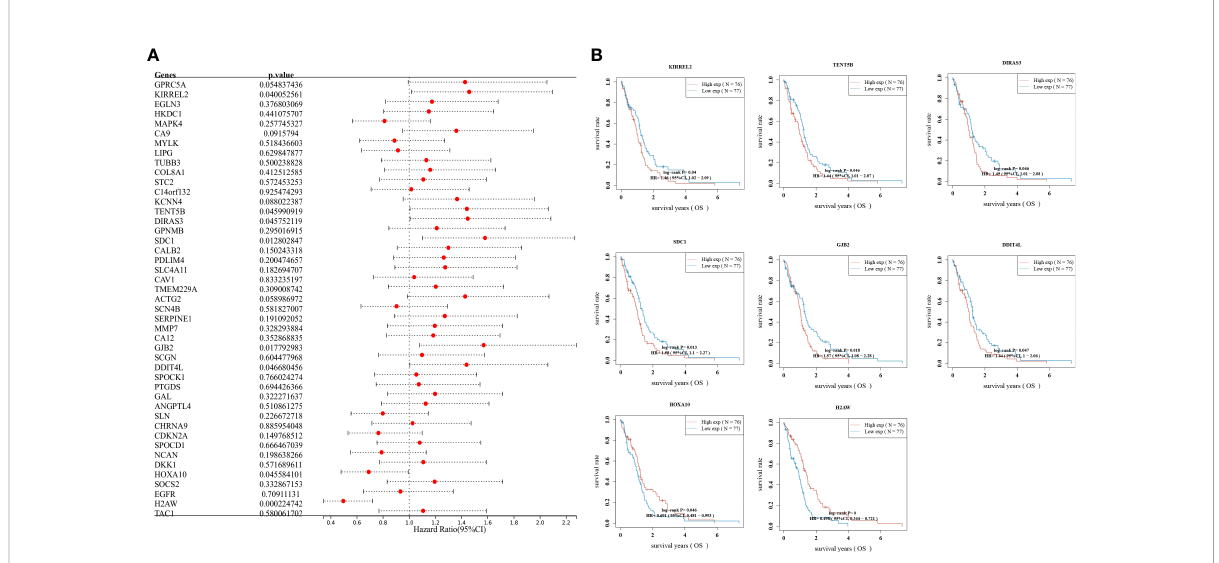
FIGURE 3 Prognostic analysis, (A) Validation of gene effects on prognosis using one-way Cox regression, presented using forest plots; (B) Kaplan – Meier survival analysis of the relationship between high and low expression levels of DDIT4L, DIRAS3, GJB2, H2AW, HOXA10, KIRREL2, SDC1, and TENT5B genes and GBM prognosis.